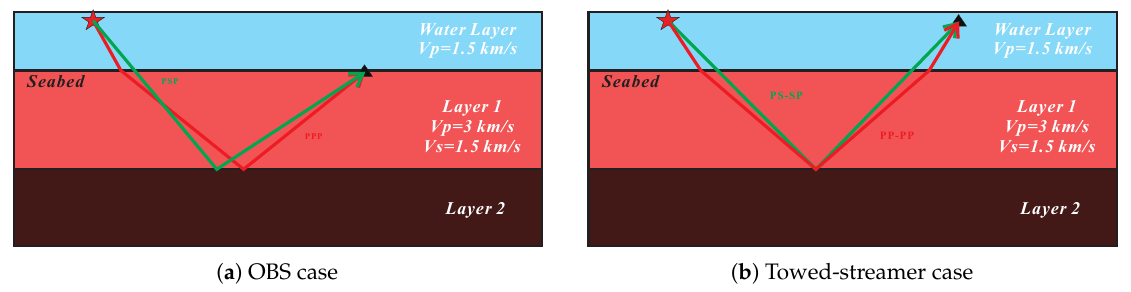
Figure 18. Cartoons of the wave propagation for 1C ( a ) ocean bottom seismic (OBS) and ( b ) towed-streamer